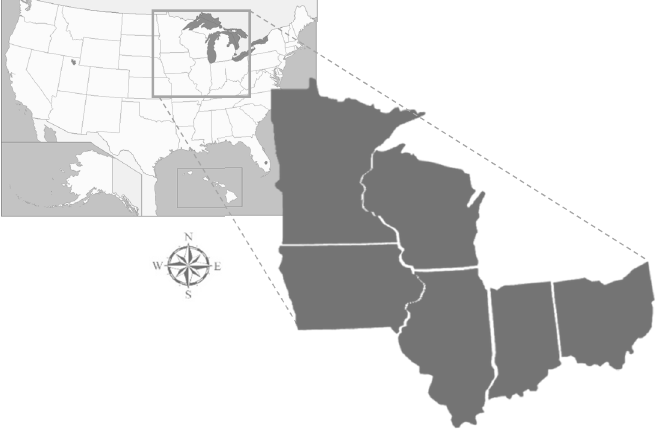
Figure 2. The six states from the North Central Region of the United States that were used in this study.